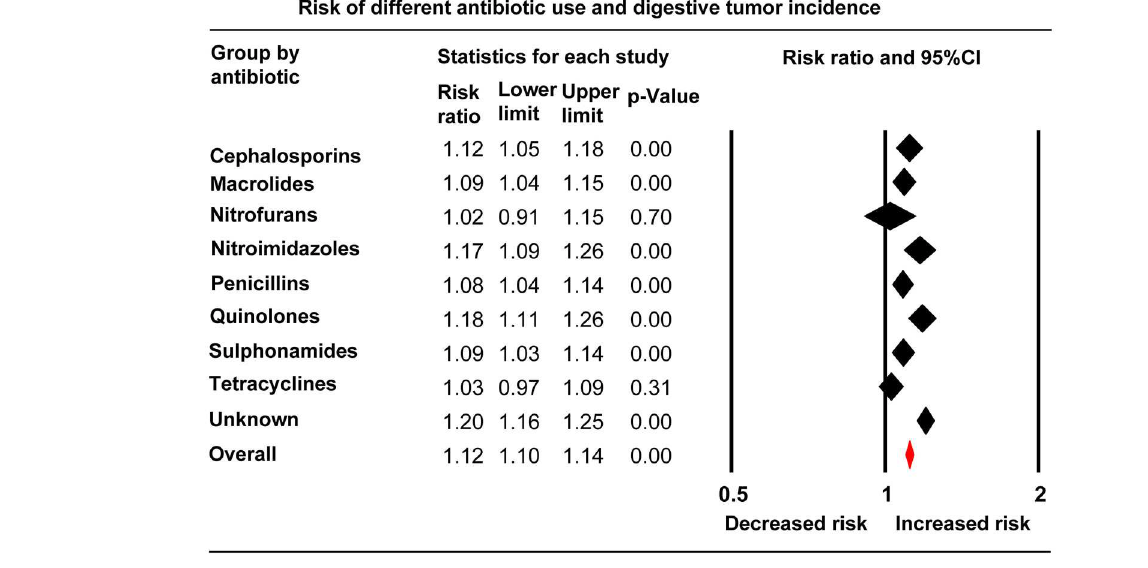
FIGURE 3 | Forest plot of anti-bacterial drug use and risks of total digestive system cancers grouped by anti-bacterial drug